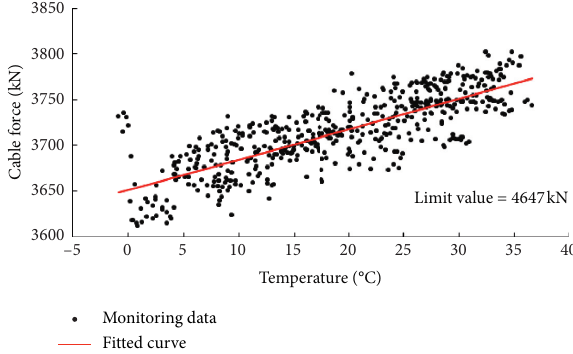
Figure 10: The relationship between separated cable force and